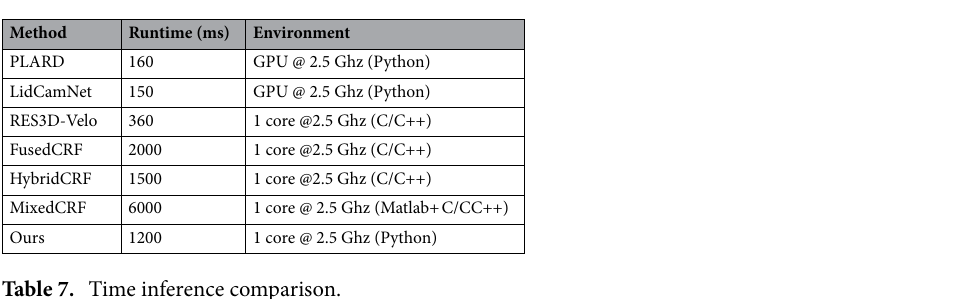
Table 7. Time inference